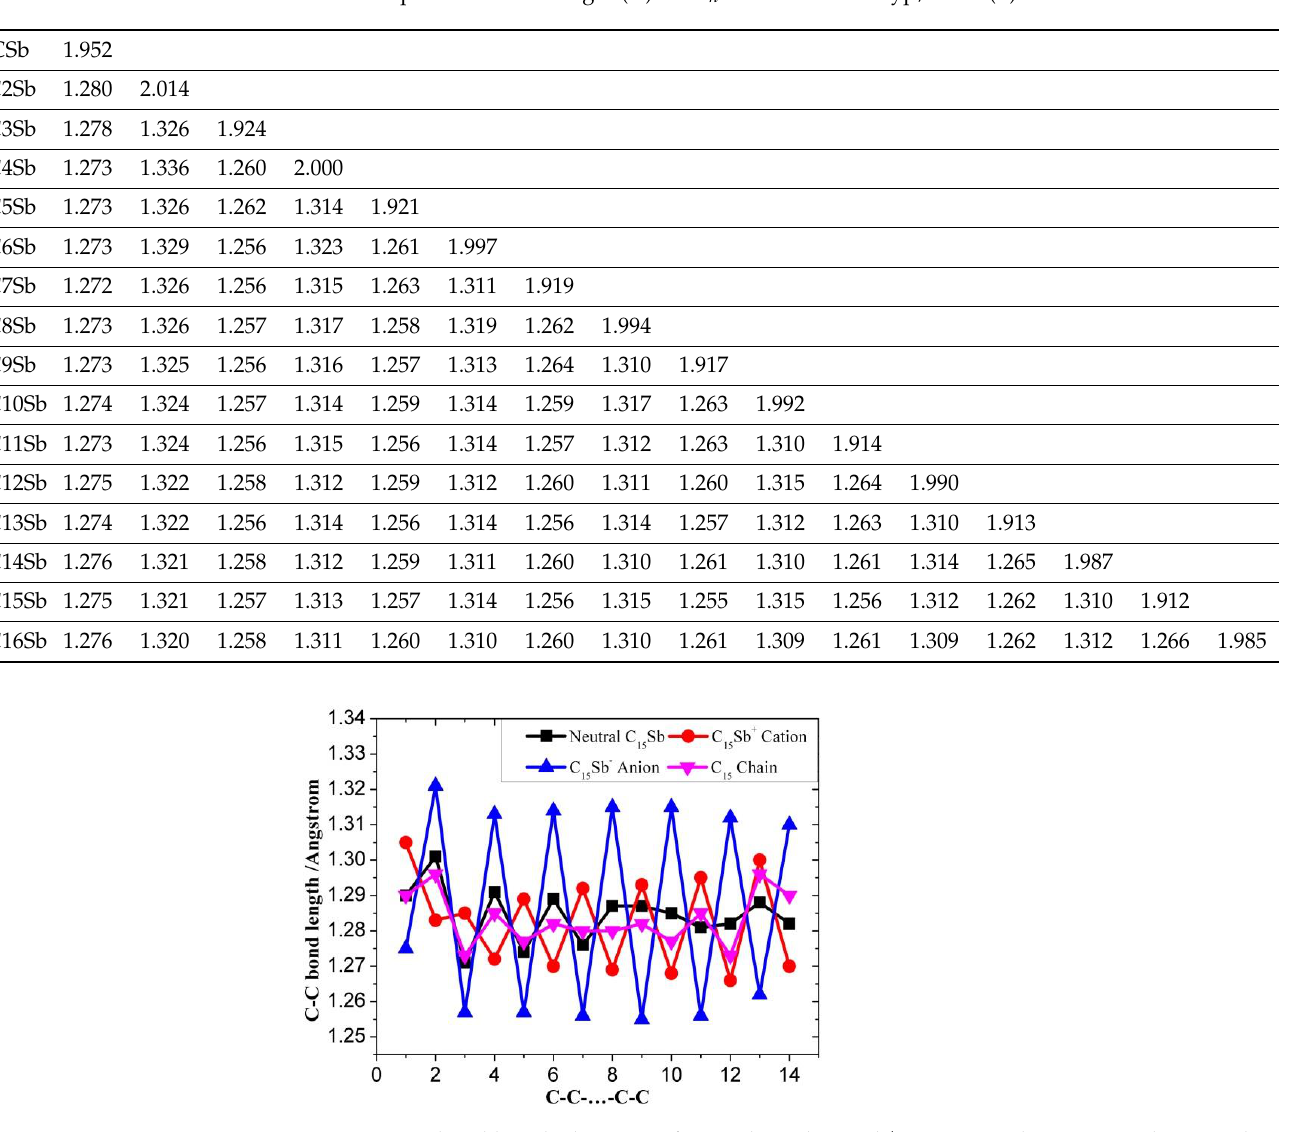
Figure 3. C-C bond length alteration of neutral C n Sb ( n = 11 – 16) as a function of number of carbon atoms. Figure 4. C-C bond length alteration of C n Sb + cations ( n = 11 – 16) as a function of number of carbon atoms.